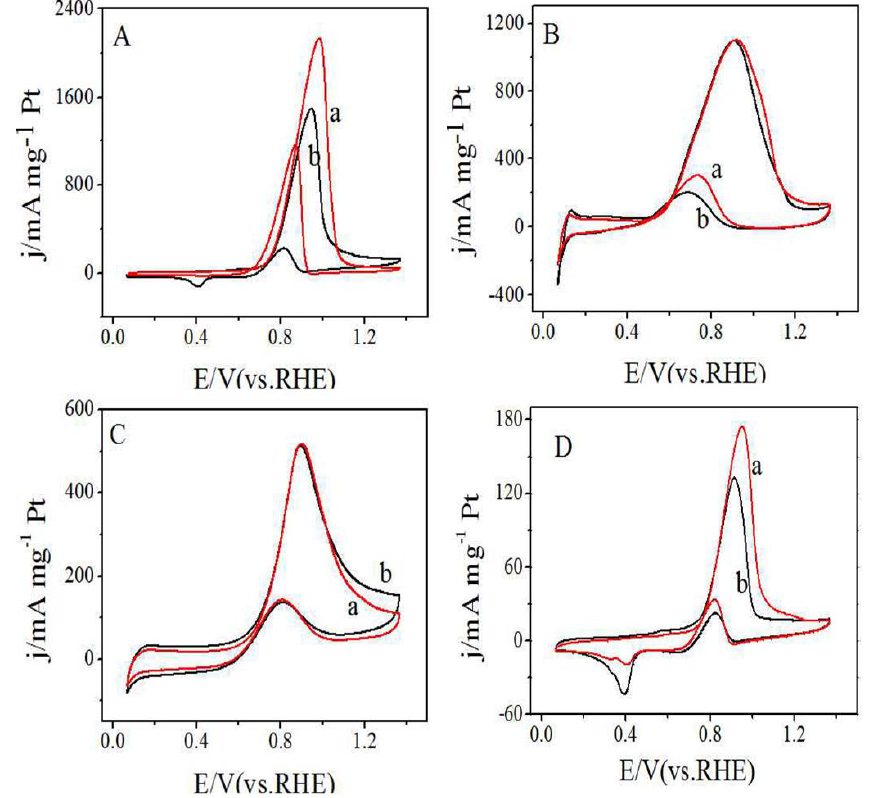
Figure 9. Cyclic voltammetry in 1.0 M CH 3 OH + 1.0 M NaOH: Pt-Bi (Bi 2 O 3 )/GNs (PVP) ( A ), 30% PtRu/C-JM ( B ), Pt/GNs (PVP) ( C ), Pt-Bi (Bi 2 O 3 )/GNs ( D ); curve a: with simulator sunlight irradiation, curve b: without irradiation.